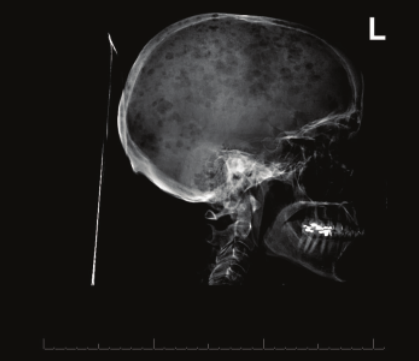
Figure 1: X-ray of the head showing multiple lucent calvarial defects described as lytic